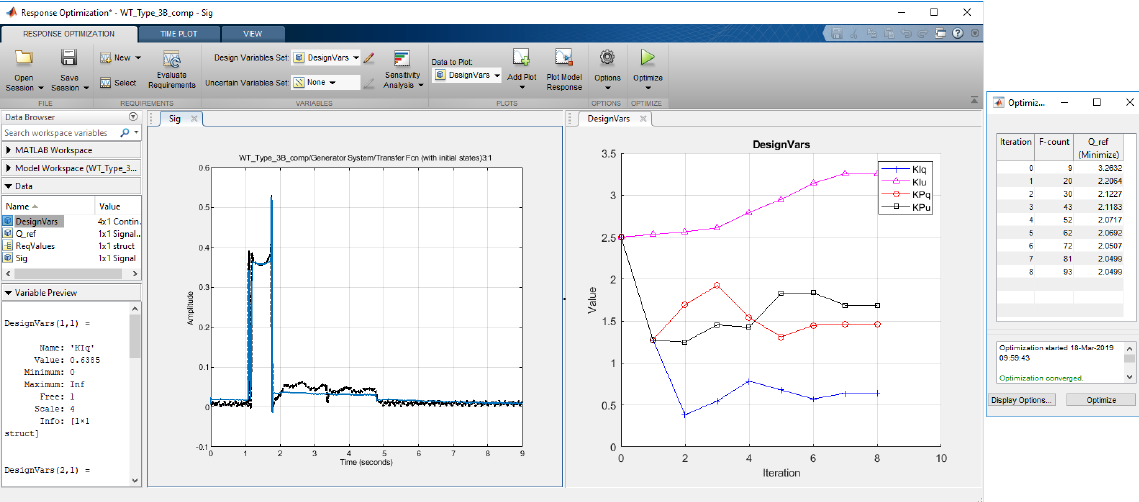
Figure 6. Simulink Design Optimization tool